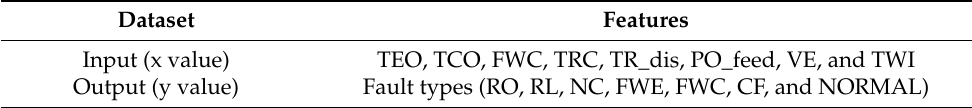
Table 3. Input and output features of the